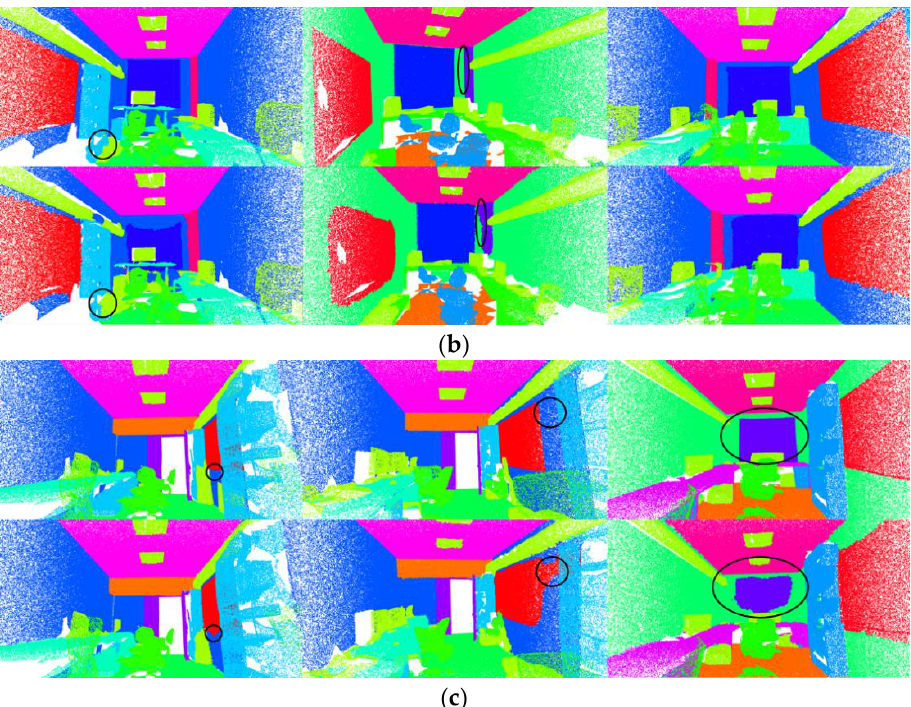
Figure 10. Results of the visualization on S3DIS. First row is the ground truth. Second row shows the prediction results, where an incorrect prediction is circled. ( a – c ) Three different scenarios in the S3DIS dataset. The figure shows the prediction results of nine different scenarios in total.